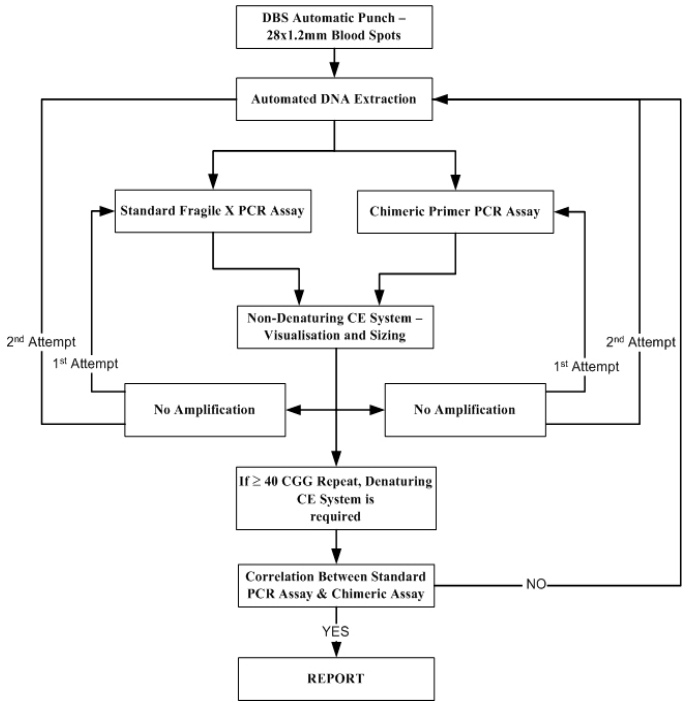
Figure 1. The fragile X pilot testing protocol.